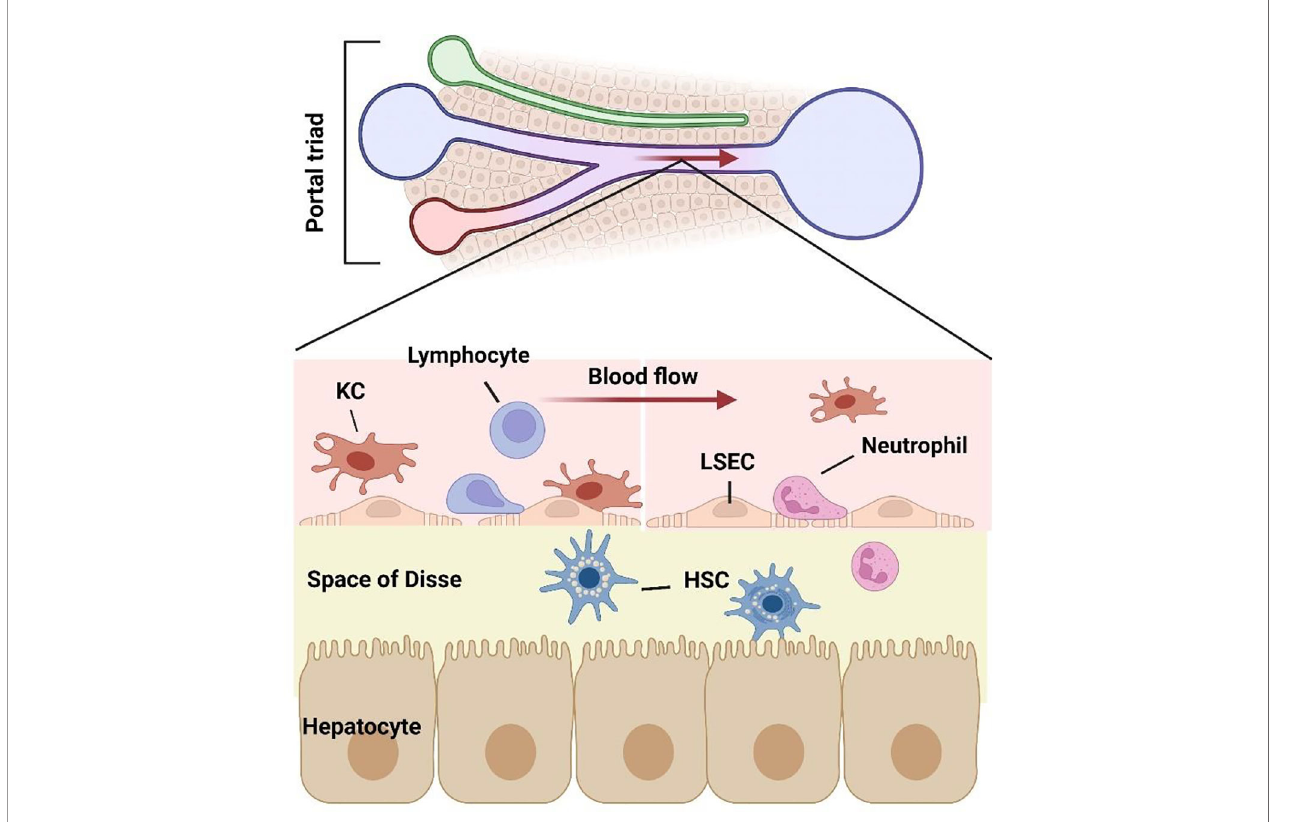
FIGURE 1 | Structure of liver sinusoidal microenvironment. As the gatekeeper of hepatic sinusoidal microenvironment, LSECs constitute the interface between the sinusoid and blood fl ow. The intercellular crosstalk between LSECs and various cells including hepatocytes, lymphocytes, neutrophils, macrophages, and hepatic stellate cells, which together consist of the hepatic